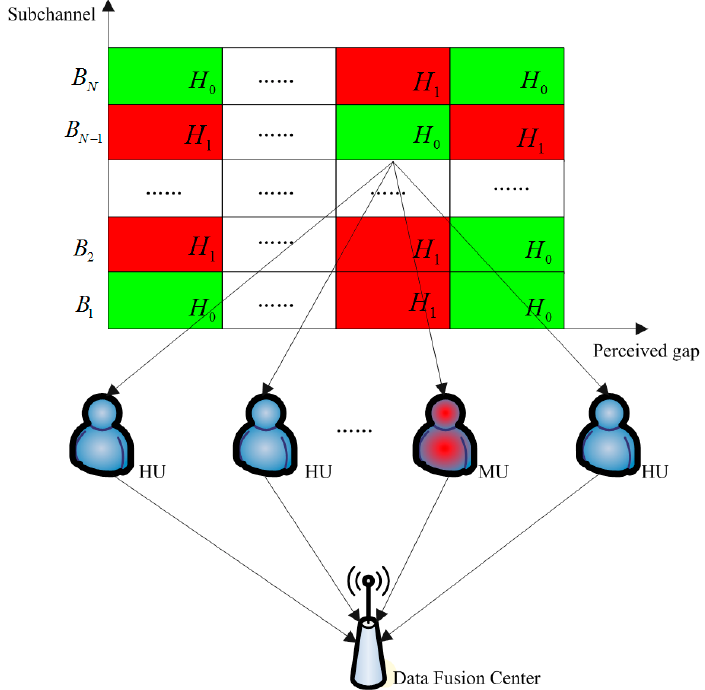
Figure 2. Single channel spectral sensing system model based on β -reputation system.